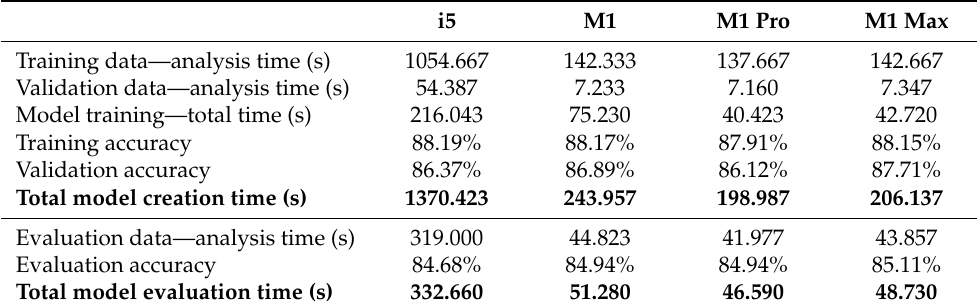
Table 8. Average test results for the ‘Animals’